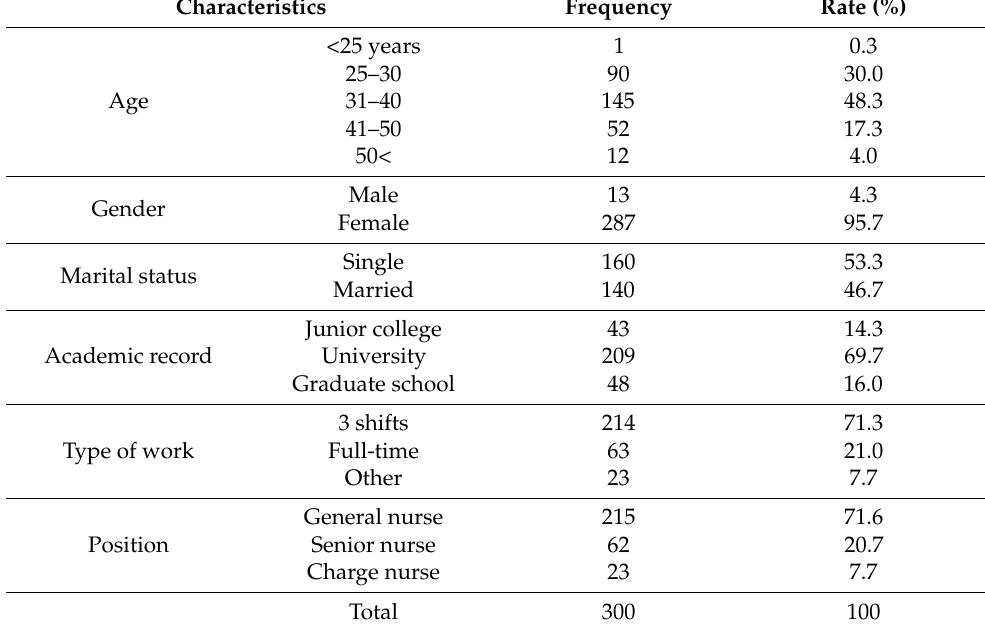
Table 1. General characteristics of participants.